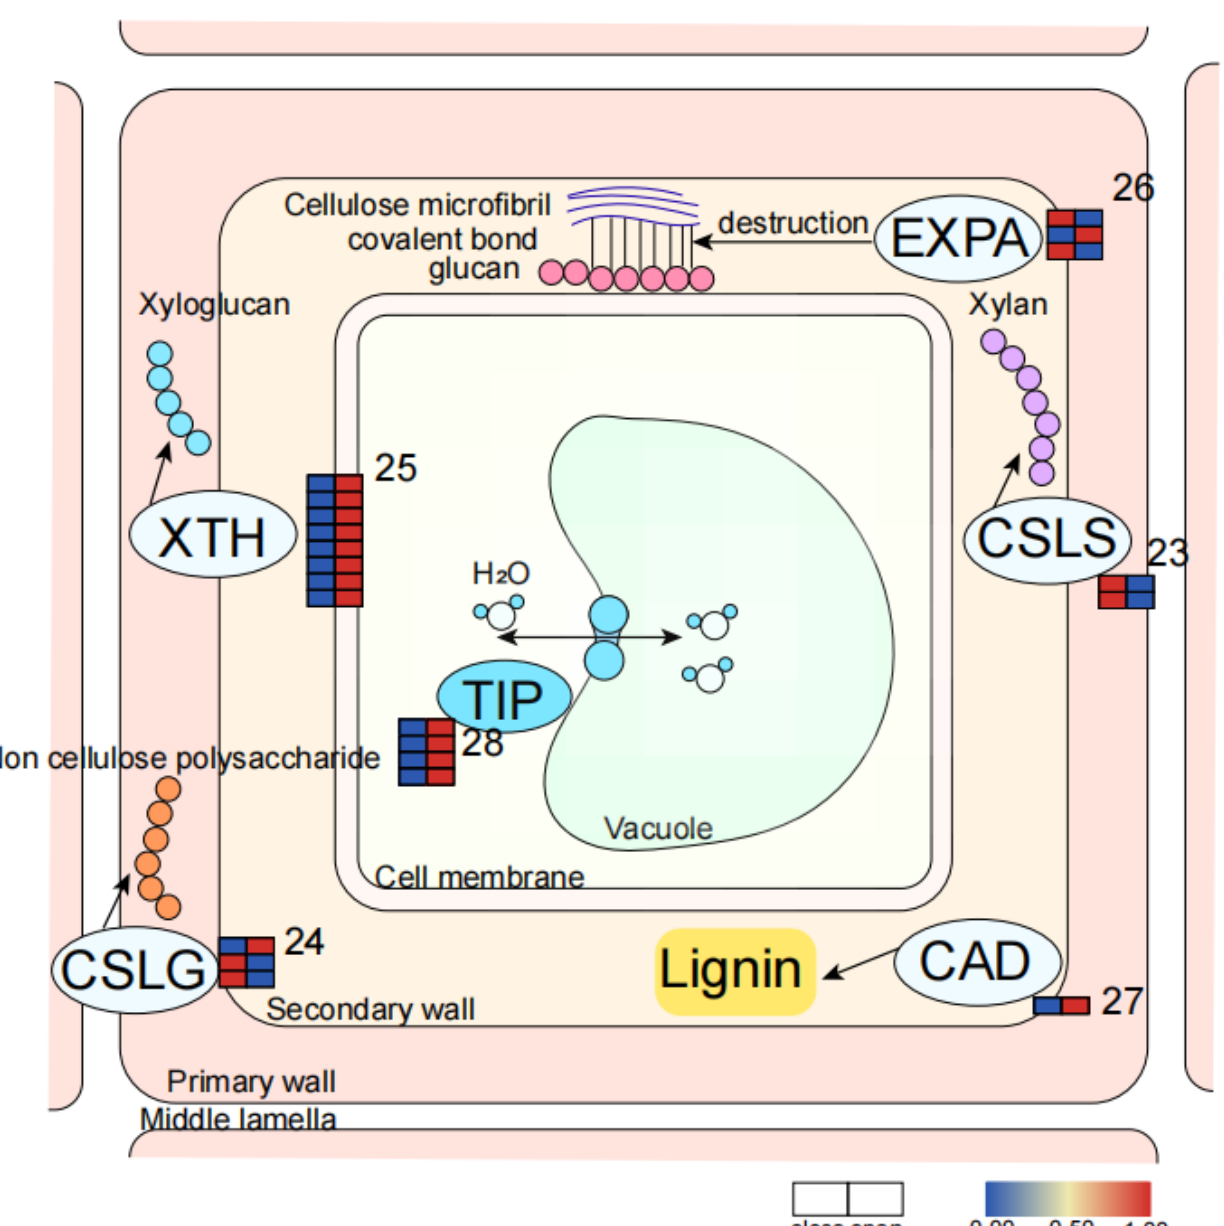
Figure 6. Expression pattern diagram of genes of the water channel pathway and cell wall modification pathway (the corresponding genes are listed in Table 3 according to the labeled number “23” to “27” in each map). Red and blue colors indicate upregulated and downregulated transcripts, respectively. Proteins of the same color represent the fact that they are in the same signaling pathway. Blue represents water transport pathways. White represents the cell wall modification pathway.